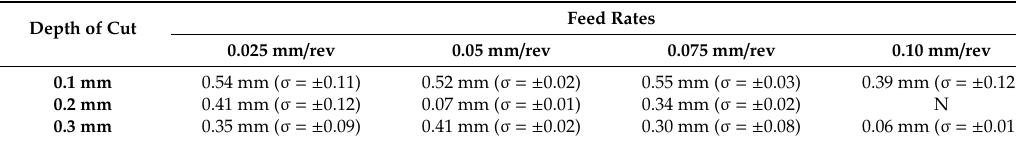
Table 6. Burr heights for TiAlN-coated tool samples.